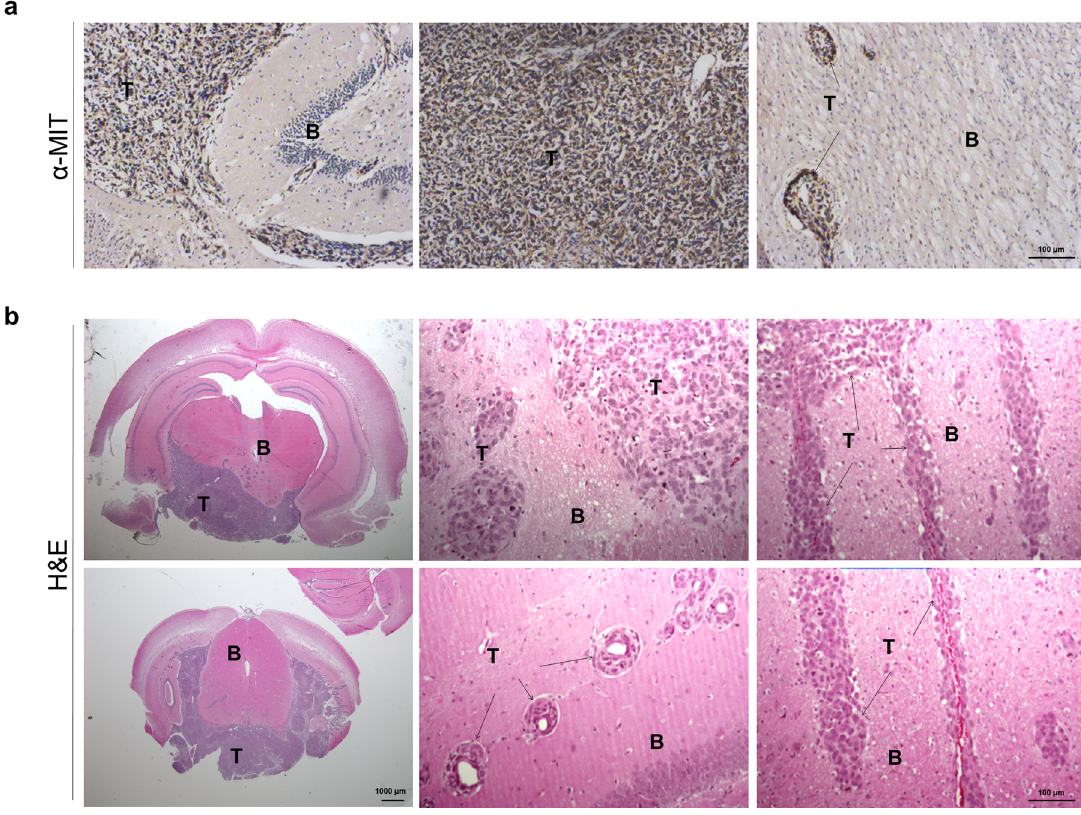
Fig. 7 Primary patient-derived cells engraft in an orthotopic NOD/SCID model recapitulating the in fi ltrative nature of glioblastoma. a Representative images of histological specimens immune-labeled with anti-human mitochondrial (MIT) monoclonal antibody (brown: DAB) con fi rmed the engraftment of intracranial injected patient-derived glioblastoma C12.FFLuc cells (T) in mouse brain (B). The scale bar: 100 µm. b Hematoxylin and eosin staining show the high in fi ltrative capacity of C12.FFLuc tumor cells (T) in mouse brain (B). First column, the scale bar is 1000 µm. Second and third columns, the scale bar: 100 µm. All sections were derived from formalin- fi xed paraf fi n-embedded brains of euthanized mice at the initial signs of distress and weight loss of up to